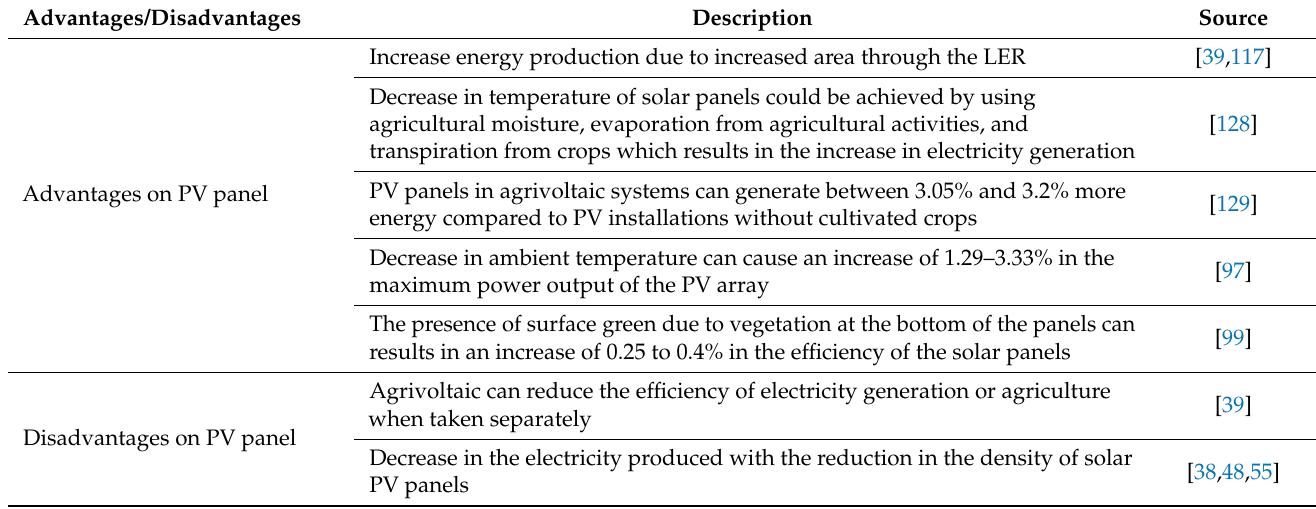
Table 3. Impacts of agrivoltaic systems on the performance of solar PV